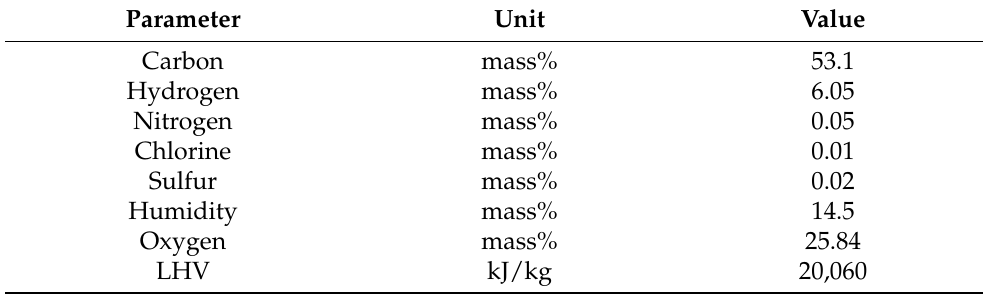
Table 1. Composition of the steam-exploded